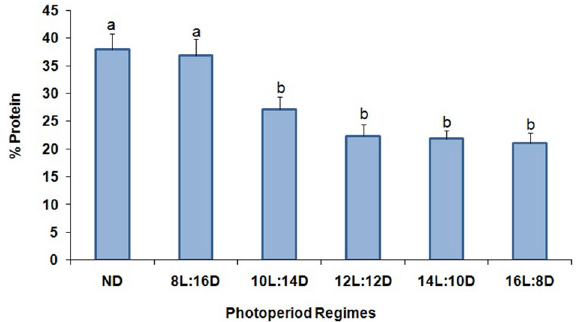
Figure 6. Percentage (% ± SE) of total protein in P. interpunctella larvae reared at 17 °C and different photoperiod regimes (means followed by the same letter are not significantly different; HSD test at 5%).